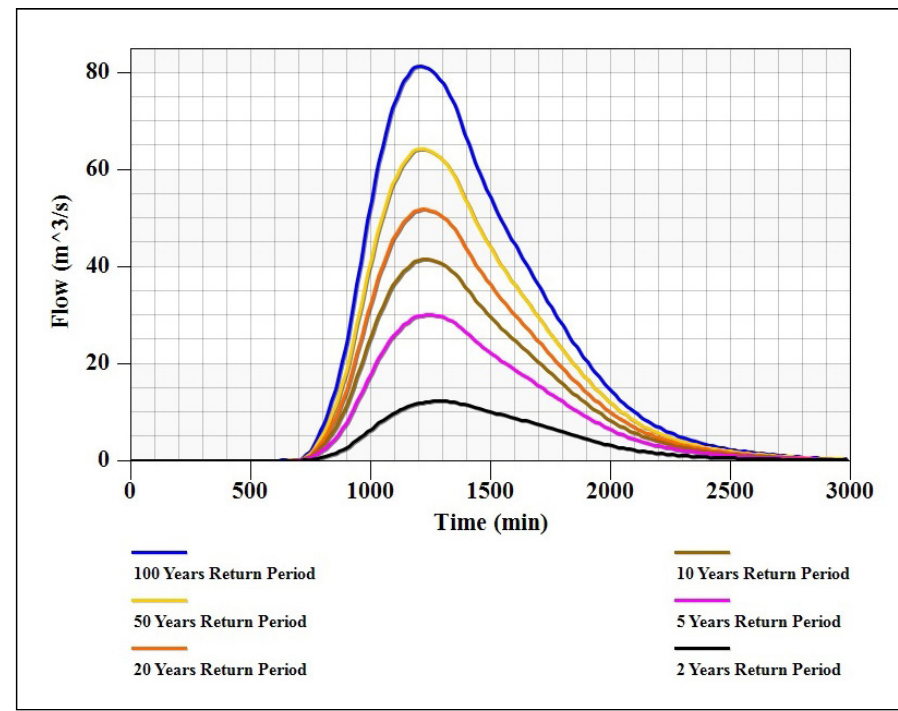
Figure 9. Hydrograph of the flood water of the Khazir River Basin for different return periods.